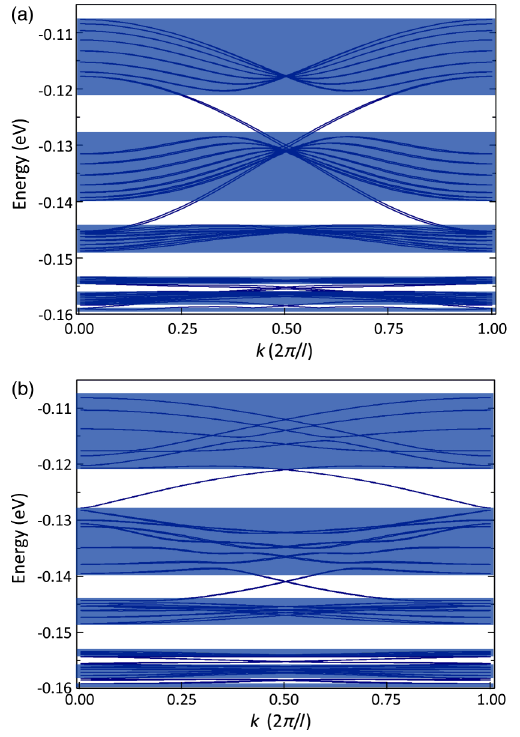
FIG. 4 (color online). Highest valence bands in ribbons made from a graphene-type honeycomb lattice of truncated nanocubes of CdSe (body diagonal of 4.30 nm). (a) Ribbon with zigzag edges (ribbon width ¼ 57 nm, periodic cell length l ¼ 8 . 2 nm). (b) Ribbon with armchair edges (ribbon width ¼ 33 nm, periodic cell length l ¼ 14 : 2 nm). In each case, the unit cell is composed of 16 nanocrystals (34768 atoms per unit cell). The colored regions indicate the bands of the corresponding 2D semiconduc- tor, i.e., those shown in Fig. 2(b).